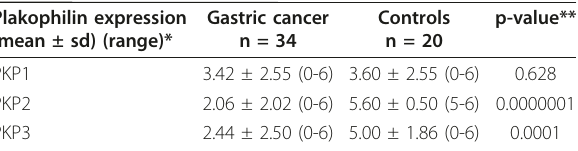
Table 2 Immunohistochemistry of gastric cancer and control